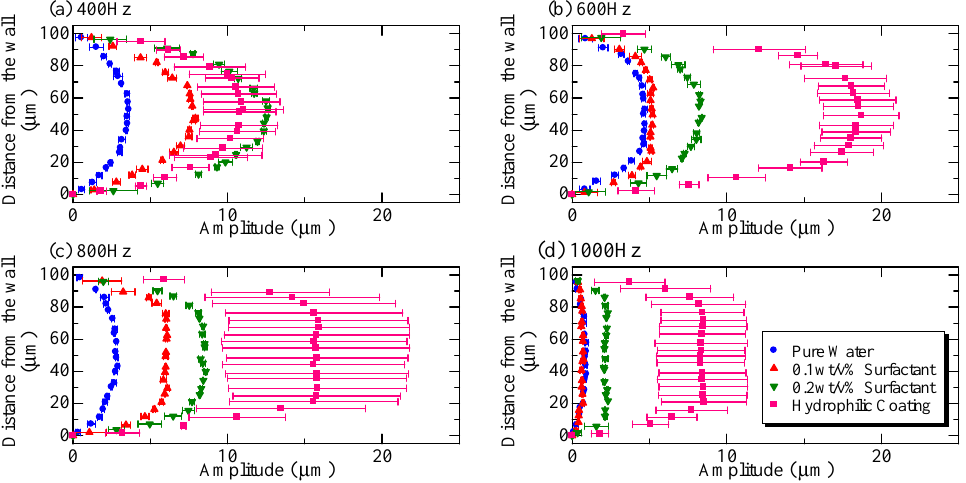
Figure A2. Amplitude profile in the straight-line channel when a vibrational force is applied at frequencies of ( a ) 400, ( b ) 600, ( c ) 800, and ( d ) 1000 Hz.